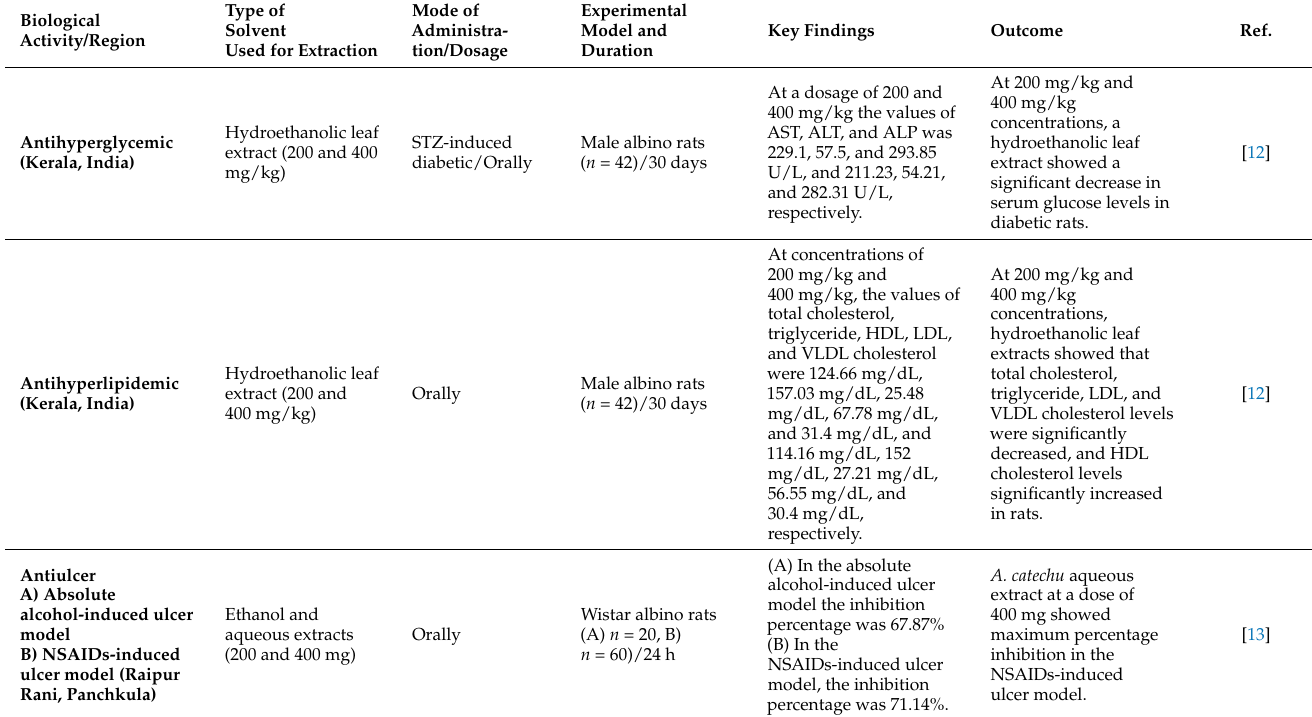
Table 4. In vivo activities of different parts of Acacia catechu